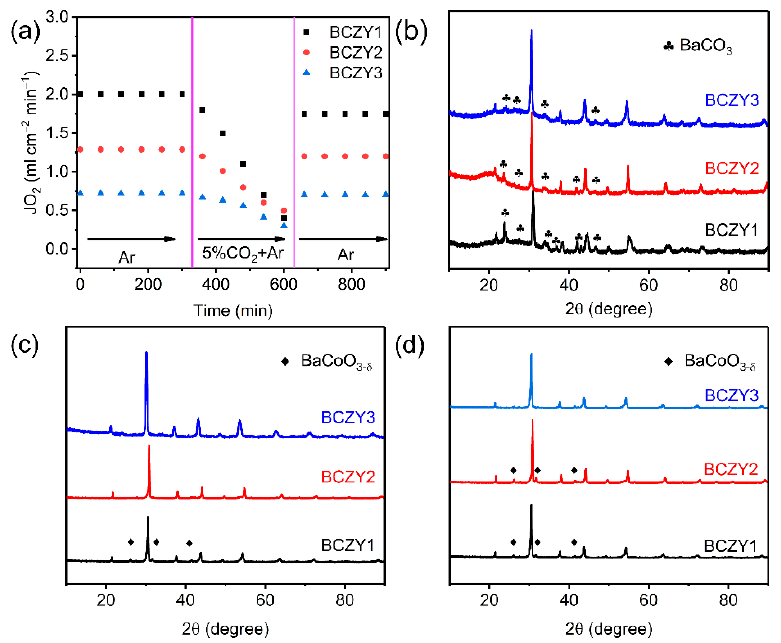
Figure 7. ( a ) Oxygen permeation rates of various BCZY membranes under Ar, CO 2 -Ar and Ar at- atmospheres at 800 ◦ C; RT-XRD patterns of BCZY1, BCZY2 and BCZY3 samples after a treatment in mospheres at 800 °C; RT-XRD patterns of BCZY1, BCZY2 and BCZY3 samples after a treatment in ( b ) 5%CO 2 + Ar, ( c ) air and ( d ) O 2 atmospheres for 20 h at 800 ◦ ( b ) 5%CO 2 + Ar, ( c ) air and ( d ) O 2 atmospheres for 20 h at 800 °C.